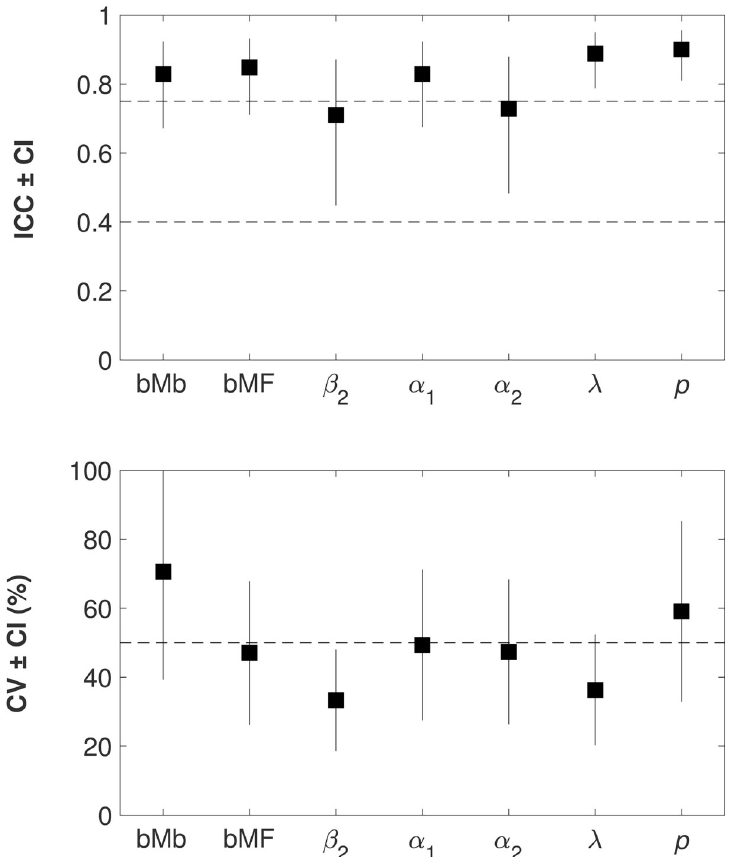
Fig 6. Test-retest reliability and repeatability of model parameters. Intraclass Correlation Coefficients (ICC < 0.4, 0.4–0.75, > 0.75 reflecting poor, moderate and excellent reliability [65]) and Coefficients of Variation (CV) of the seven parameters (bMB, bMF, β 2 , α 1 , α 2 , λ , p ). See Table 5 for